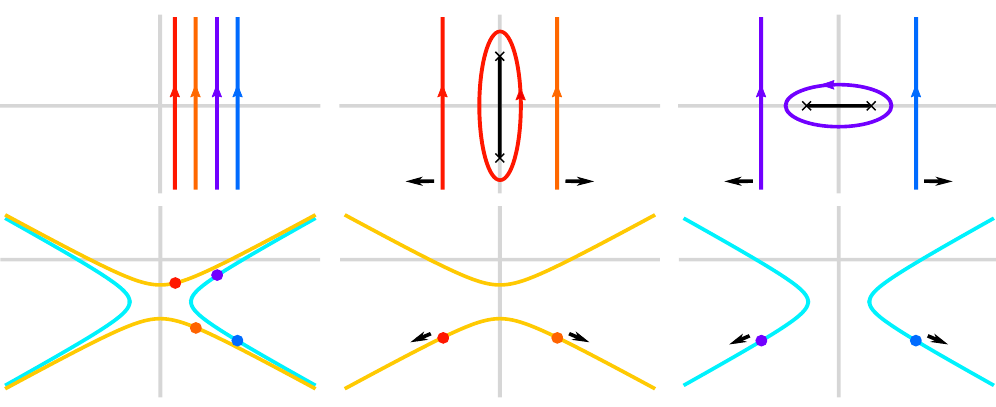
Figure 16 . A plot of the ν integration along the Regge trajectories, following figure 10. The warm and cool colours correspond to the J even and J odd solutions,